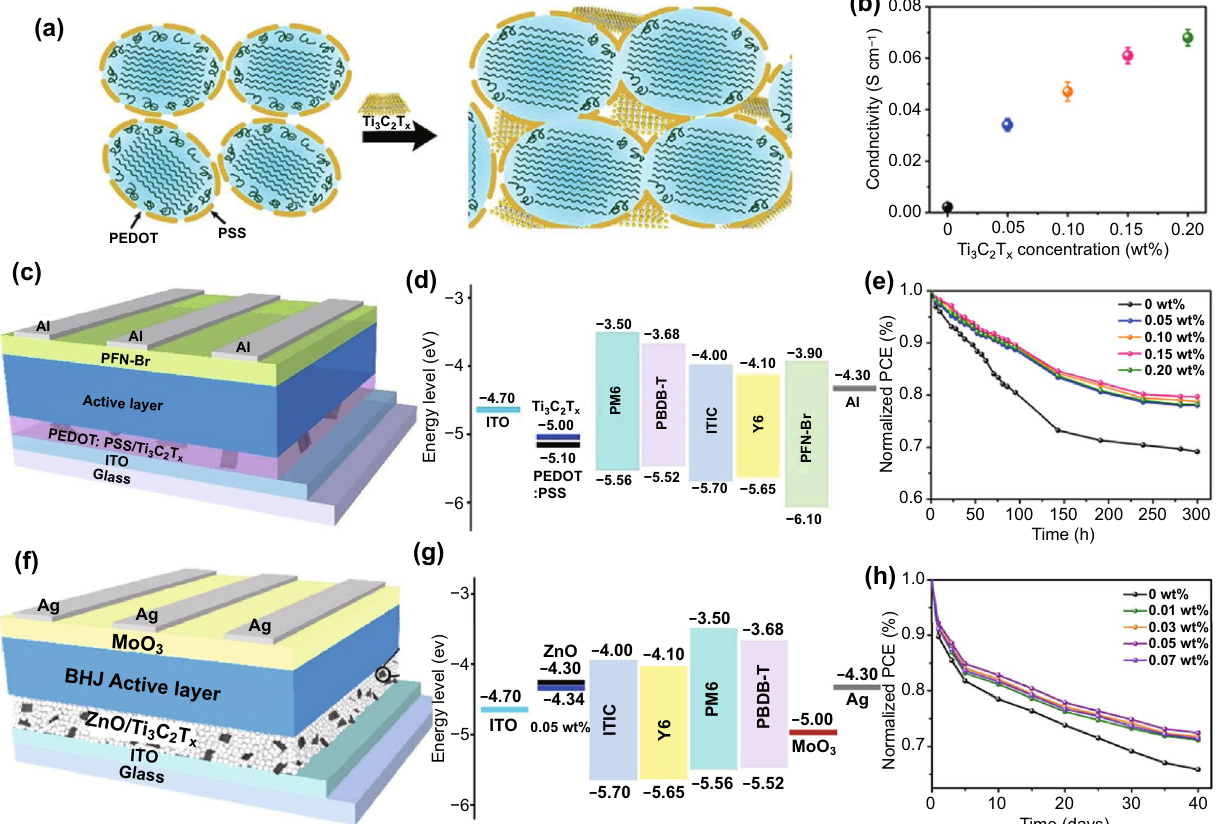
Fig. 4 a Schematic illustration of morphological and structural modification in PEDOT:PSS with incorporation of the Ti 3 C 2 T x MXene nanosheets. b Electrical conductivity of PEDOT:PSS with varying Ti 3 C 2 T x additions on bare glass. c Device configuration and d energy-level diagram of each component for the OSC using Ti 3 C 2 T x -modified PEDOT:PSS as the HTL. e Stability test for the devices with varying Ti 3 C 2 T x additions based on the PBDB-T:ITIC photoactive layer measured in a N 2 glove box. Copyright © The Royal Society of Chemistry. f Device con- figuration and g energy-level diagram of each component for the OSC using ZnO/Ti 3 C 2 T x as the ETL. h Stability test of the devices based on the PBDB-T:ITIC photoactive with varying Ti 3 C 2 T x additions without encapsulation in air. Copyright © 2020 Elsevier